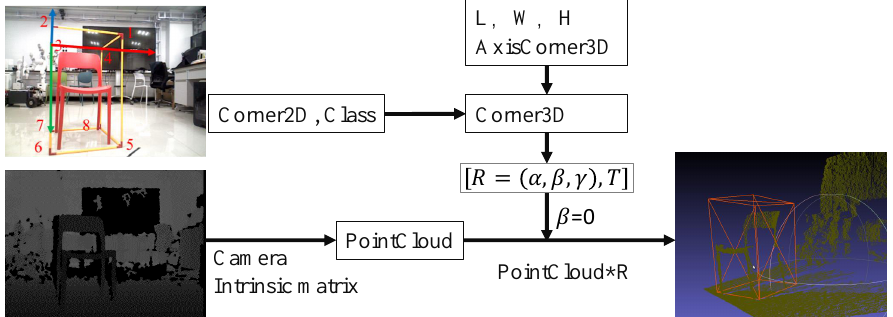
Figure 7. The block diagram of the proposed PNP-based annotation tool for 3D object